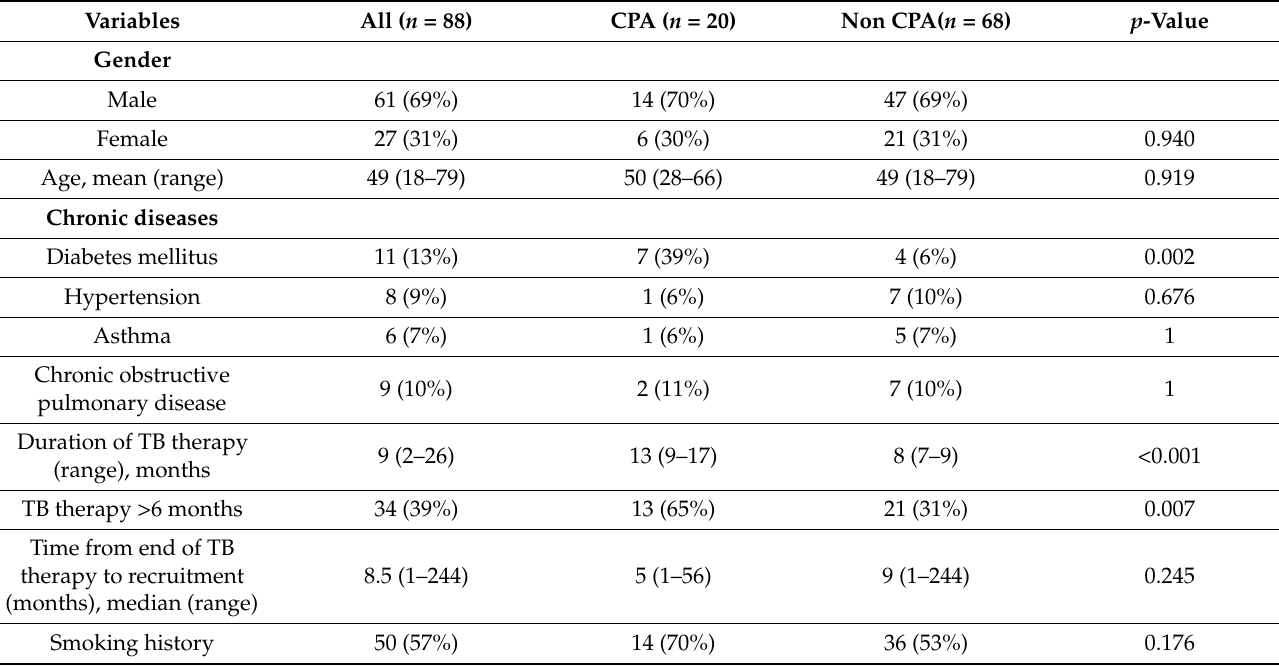
Table 1. Patient